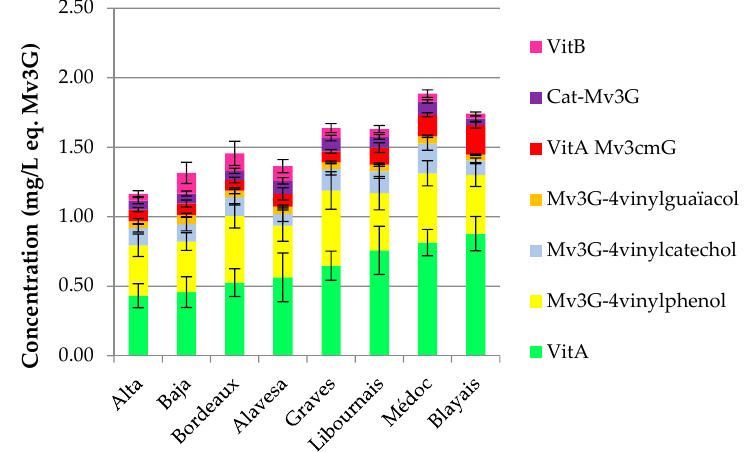
Figure 1. Pyranoanthocyanins and polymerized pigments for each wine-growing region. VitB , vitisin B; Cat-Mv3G, direct catechin-malvidin-3- O -glucoside adduct; VitA Mv3cmG, vitisin A-malvidin-3- O - p -coumaroylglucoside; Mv3G-4-vinylguaiacol, pyranomalvidin-3- O -glucoside-4-vinylguaiacol; Mv3G-4-vinylcatechol, pyranomalvidin-3- O -glucoside-4-vinylcatechol; Mv3G-4-vinylphenol, pyranomalvidin-3- O -glucoside-4-vinylphenol; VitA, vitisin A. Error bars are standard deviation of wine samples within each category.